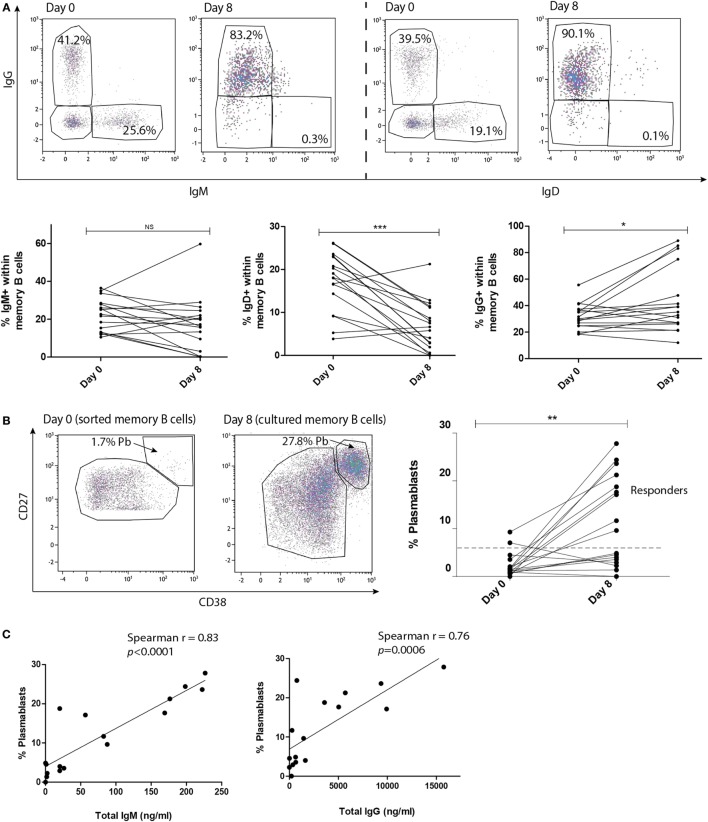
T follicular helper (Tfh)-mediated B cell differentiation occurs upon stimulation with alloantigen. Tfh and memory B cells were stimulated with alloantigen and cocultured for 8 days. (A) Gating strategy of surface immunoglobulins IgM, IgD, and IgG within the memory B cell population before and after coculture and corresponding quantified data (n = 17). (B) Gating strategy of CD27highCD38high plasmablasts and remaining memory B cells at baseline (day 0) and after 8 days coculture is depicted on the left. Quantified data of plasmablast proportions at day 0 and after 8 days coculture are depicted on the right. Dashed line distinguishes between cultures with a high plasmablast proportion (>10%) compared to a low plasmablast proportion (<5%) at day 8 (n = 17). (C) Correlation between proportion of plasmablasts and IgM or IgG (ng/ml) in the culture supernatant after 8 days coculture (n = 16) (*p < 0.05, **p < 0.003, ***p < 0.0009). Pb, plasmablast.